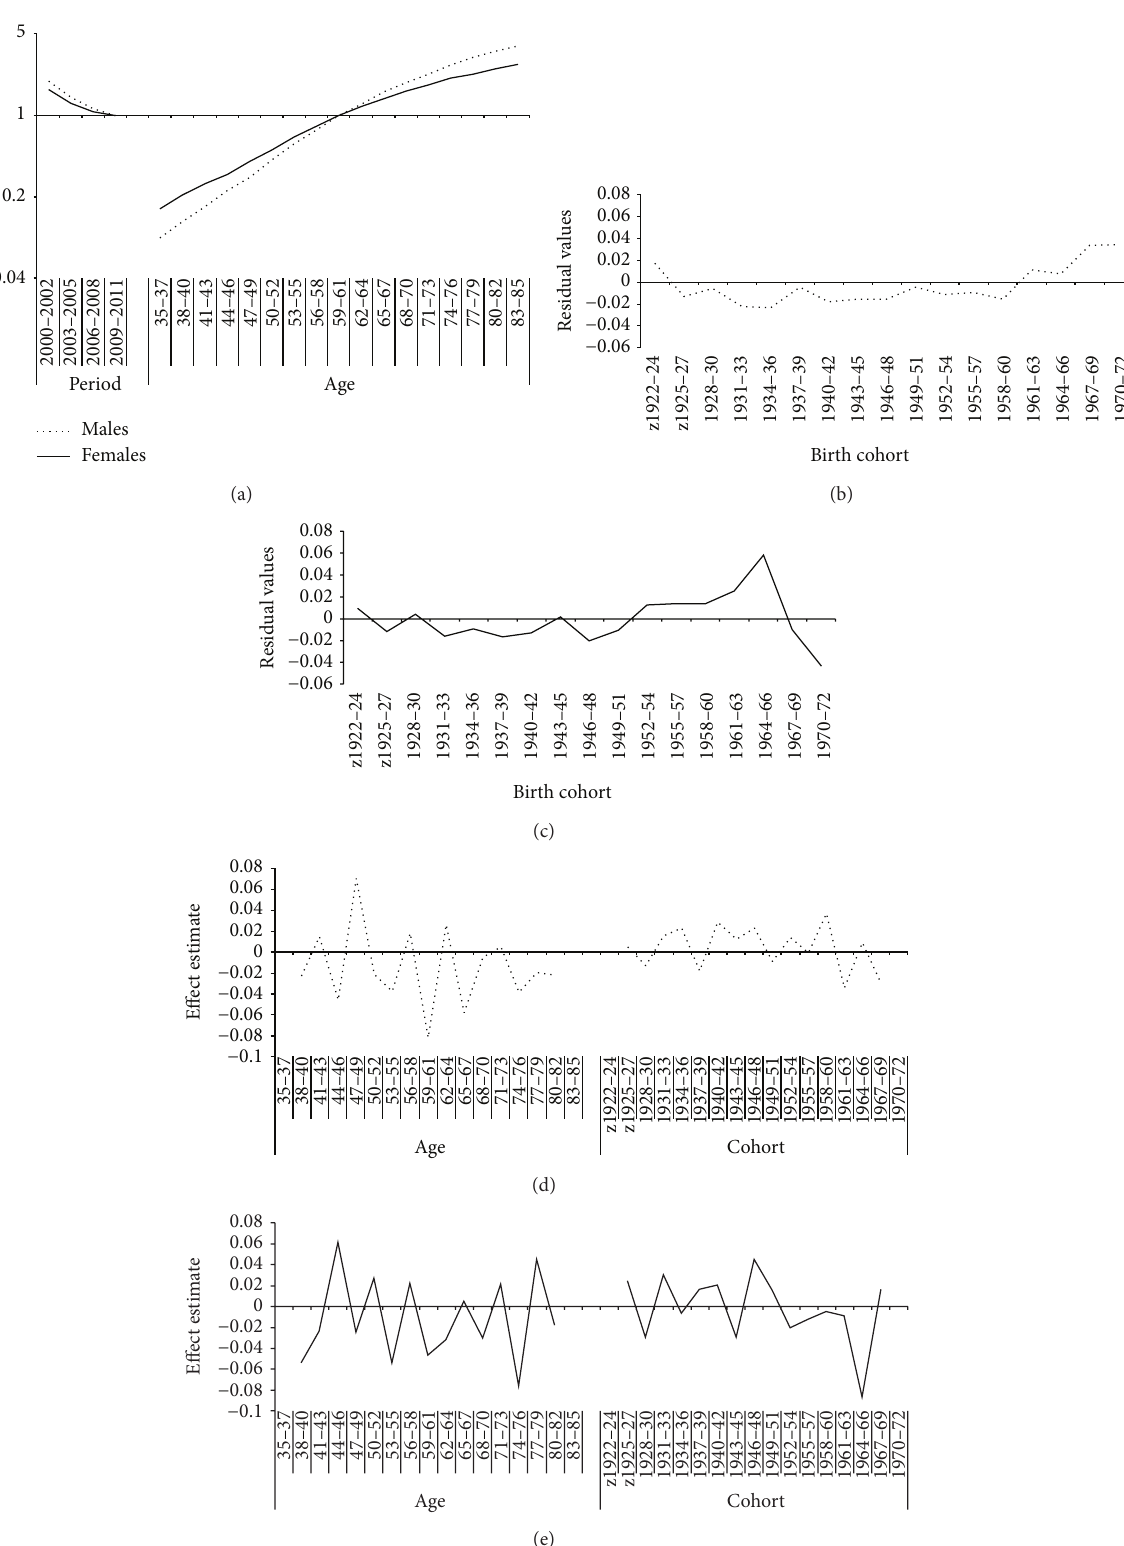
Figure 4: Age-period-cohort effects in COPD incidence rates for males and females. (a) Age and period effects, by sex. (b) Cohort effect in men (median Polish method). (c) Cohort effect in females (median Polish method). (d) Cohort effect in men (Holford method). (e) Cohort effect in females (Holford